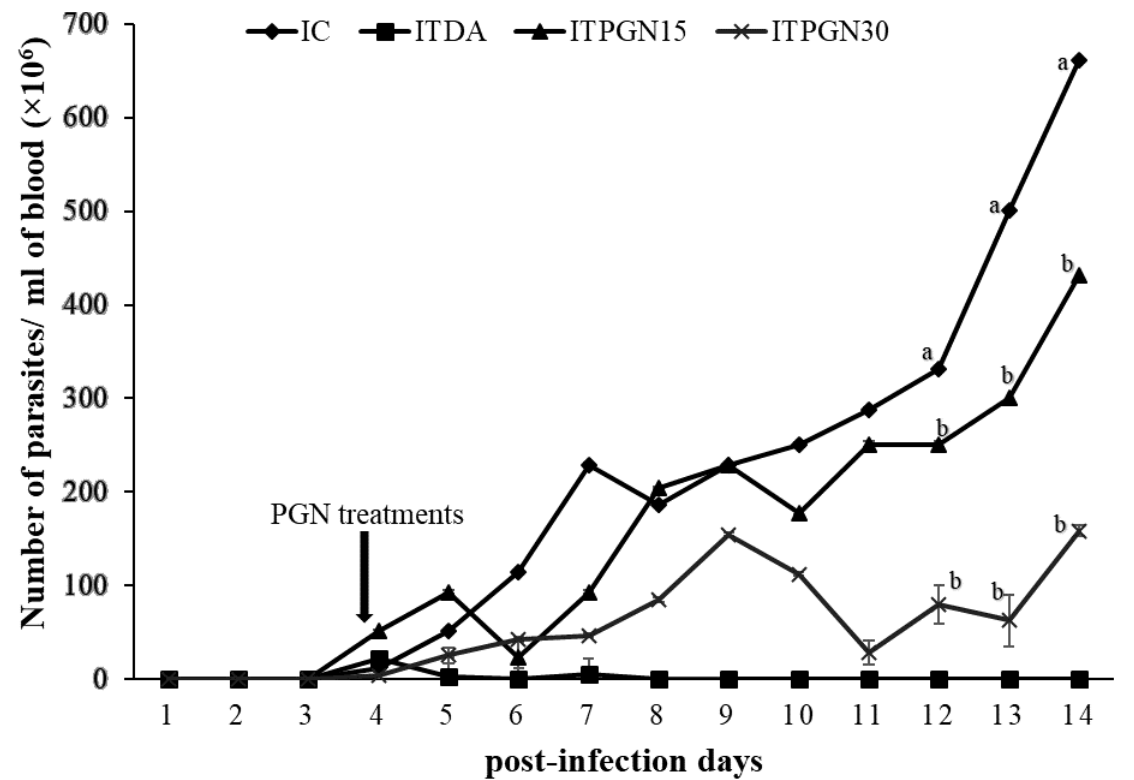
Figure 2. Evaluation of parasitemia in T. congolense -infected rats treated with different doses of phloroglucinol. All data are presented as mean ± standard deviation of seven rats. Dunnett posthoc test was used to analyze the data following ONE-WAY ANOVA. IC was used as control. Values with different subscripts are considered statistically significant at p < 0.05. IC = infected control, ITPGN15 = Infected + 15 mg/kg BW PGN, ITPGN30 = Infected + 30 mg/kg PGN, ITDA = Infected + 3.5 mg/kg BW DA.